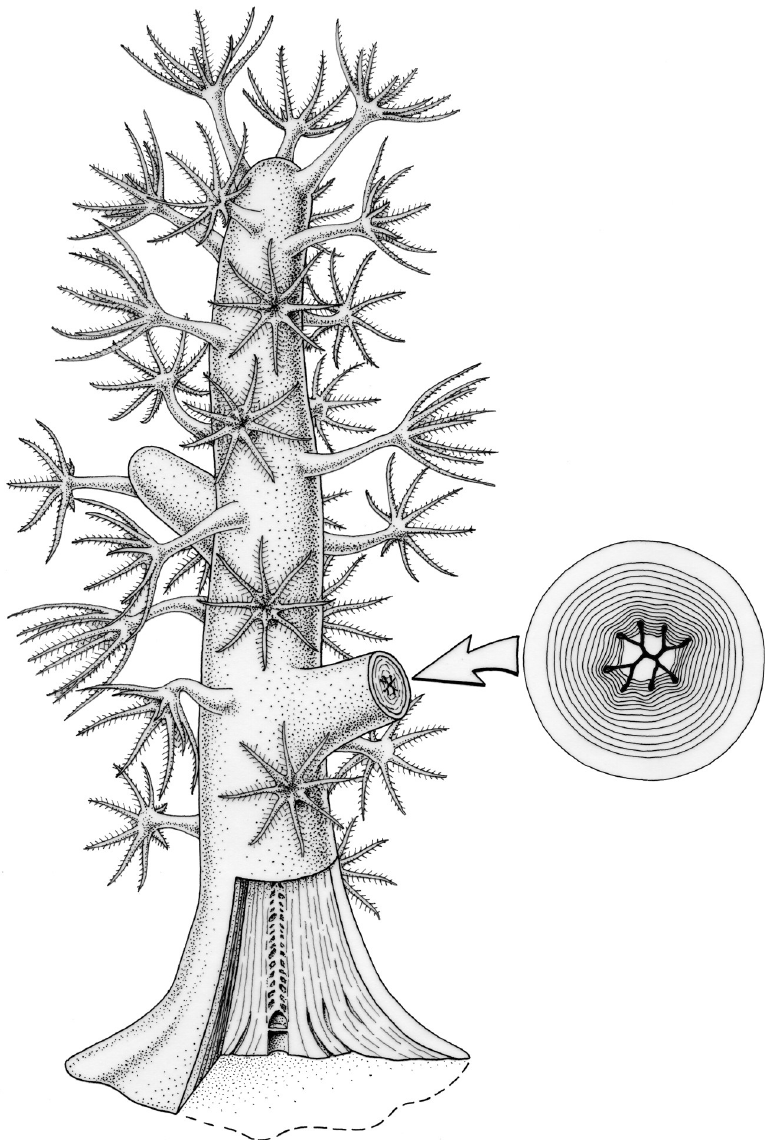
Fig 11. Reconstruction of the juvenile colony of Oligophylloides . Drawing by B. Waksmundzki.